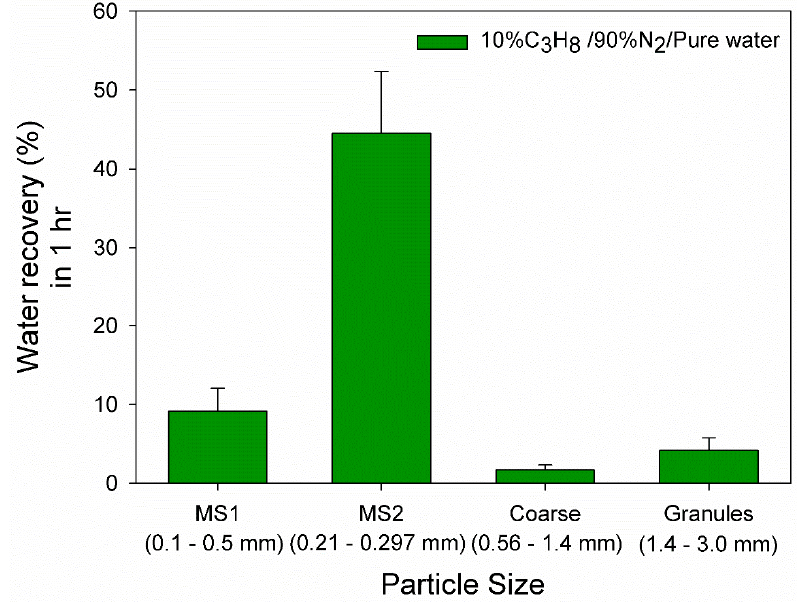
Figure 3. Effect of silica sand particle size on water recovery for 10% propane in nitrogen in pure water.